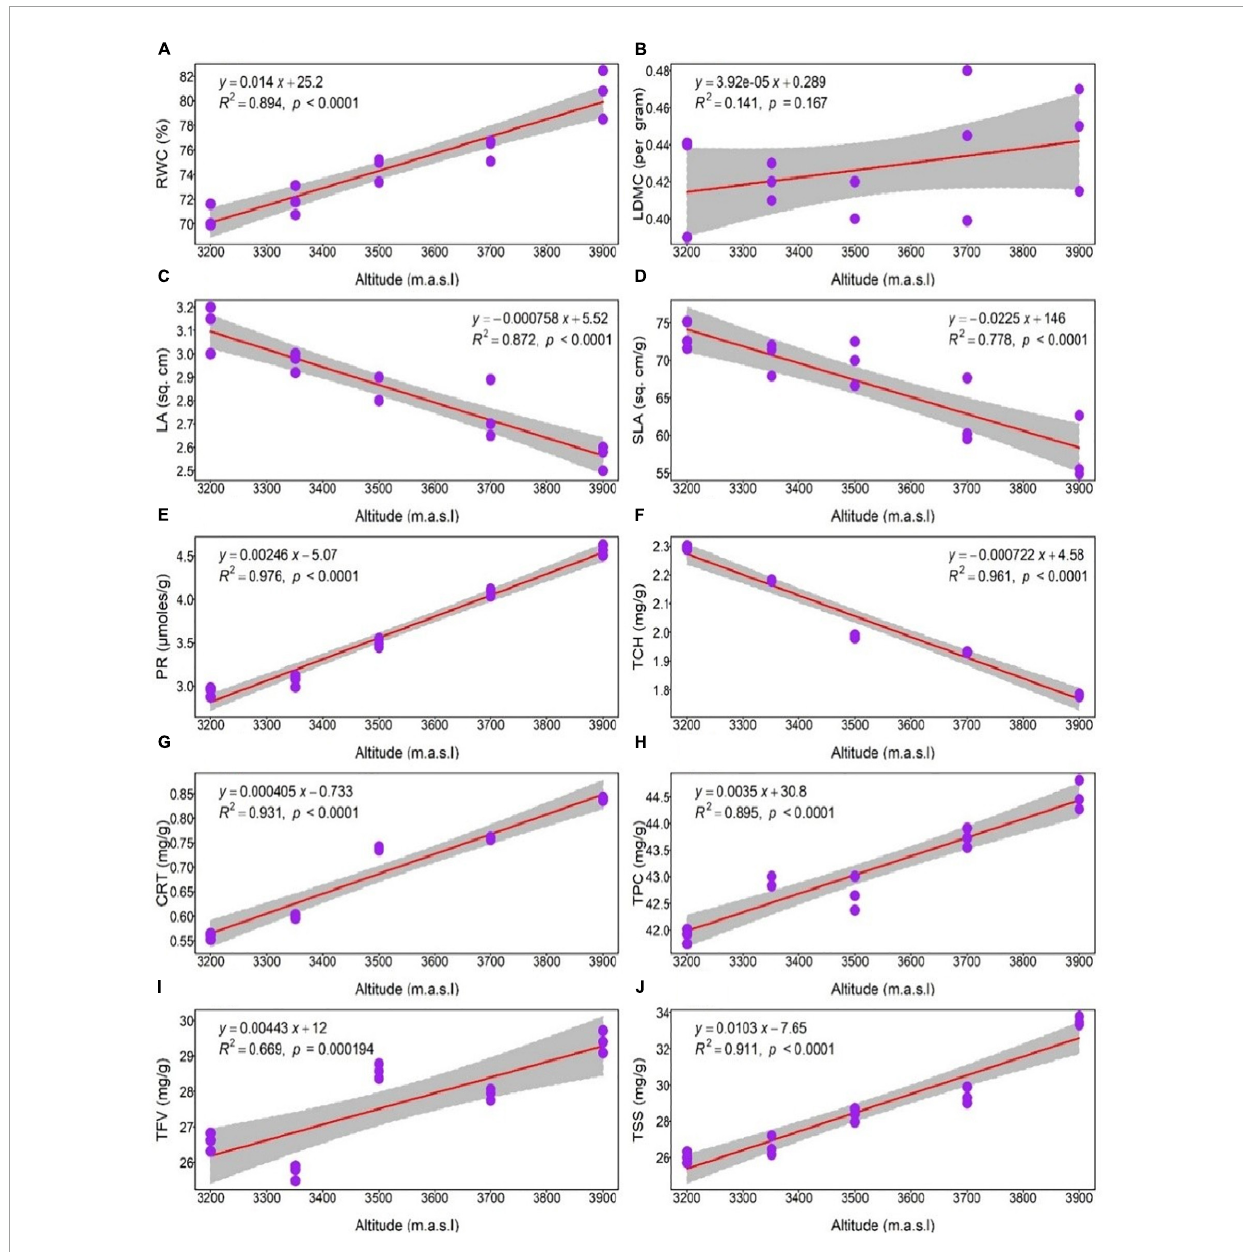
FIGURE5 Linear regression representing a change in eco-physiological parameters of Rhododendron anthopogon along the altitude gradient. Relationship between altitude and (A) RWC, relative water content; (B) LDMC, leaf dry mass content; (C) LA, leaf area; (D) SLA, specific leaf area; (E) PR, proline content; (F) TCH, total chlorophyll; (G) CRT, carotenoid content; (H) TPC, total phenolics content; (I) TFV, total flavonoids; (J) TSS, total soluble sugars. Each purple dot in the plot represents the mean value of the eco-physiological parameters, and the gray areas represent a 95% confidence